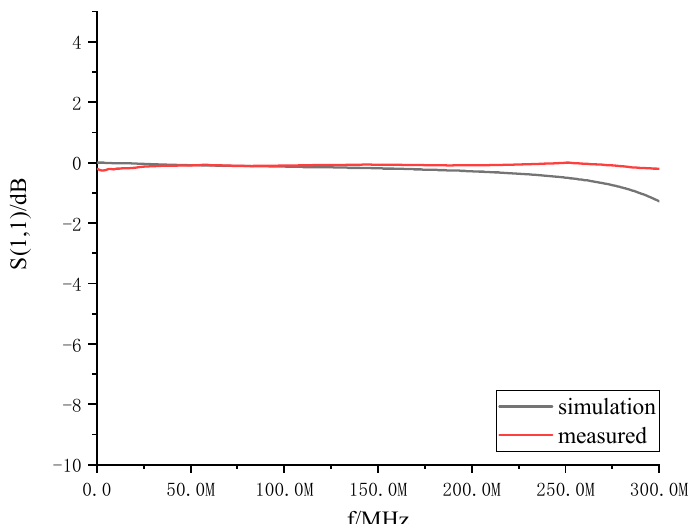
Figure 16. Schematic diagram of 12 S and 11 S parameters measured in practice.